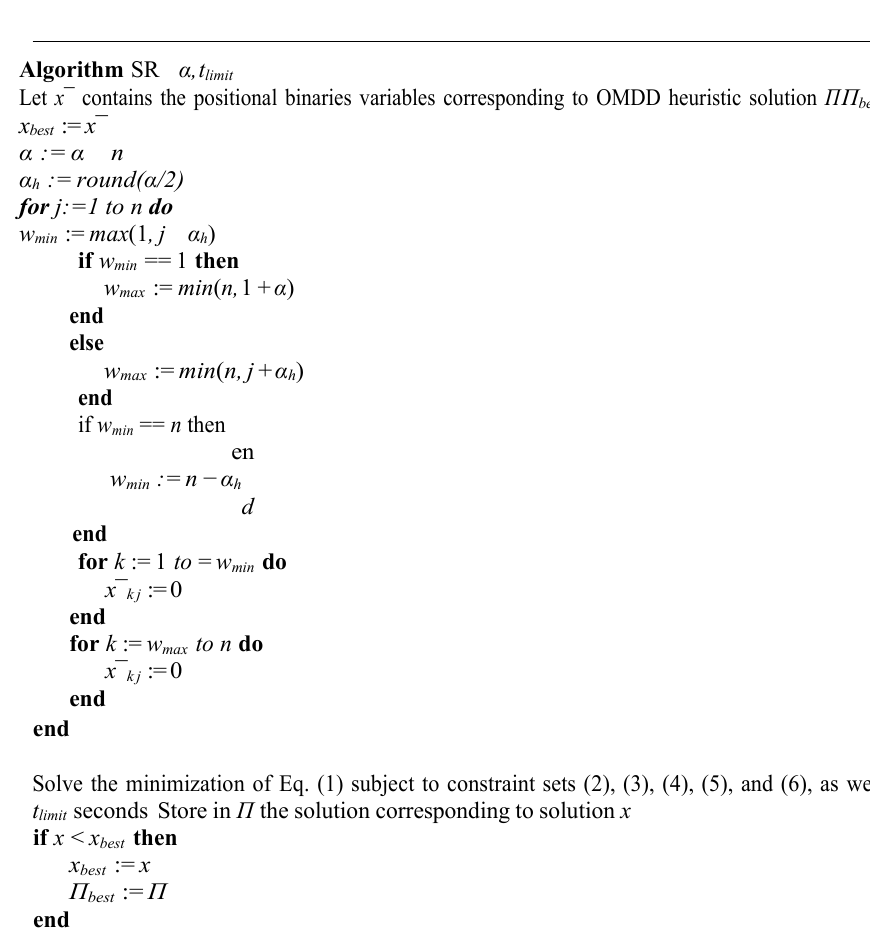
Fig. 3. Pseudocode of the proposed SR